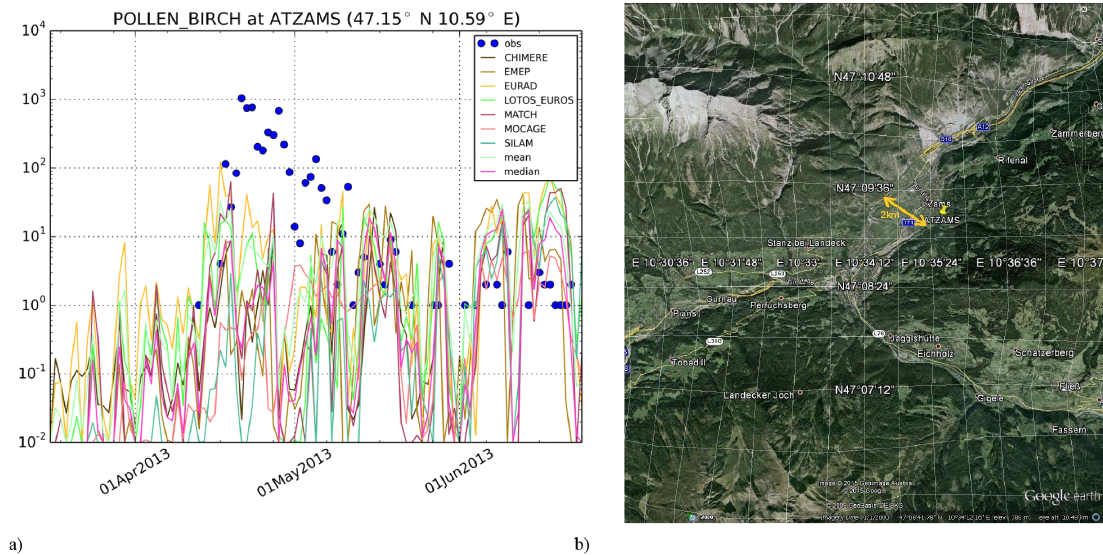
Figure 9. Daily time series for Zams station in Austrian Alps ( a , pollenm − 3 ) and location of the station (yellow pin) in the 2km wide valley (b) . Due to the log-scale, zero observations are